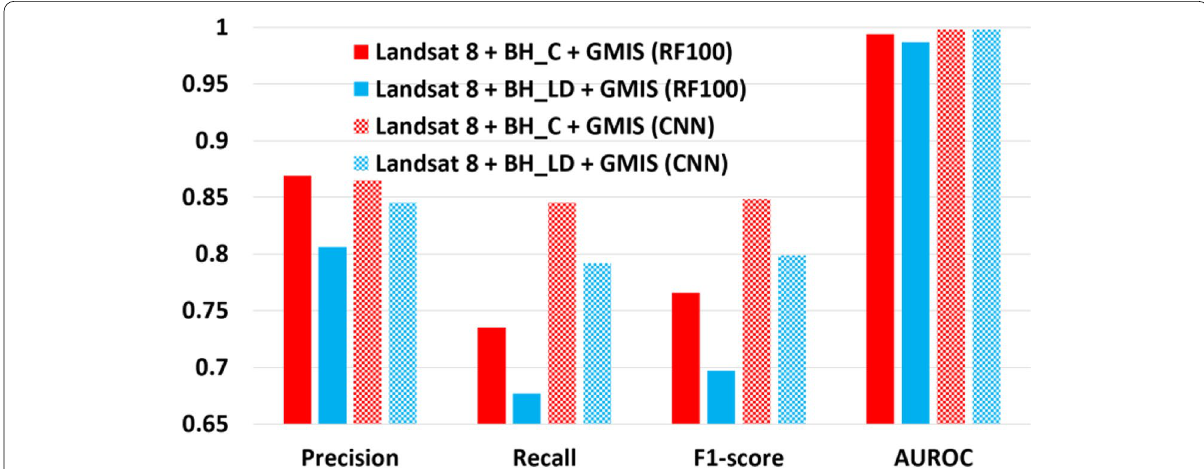
Fig. 15 The macro indices (precision, recall, F1‑score, and AUROC) for different BH datasets, BH_LD (red) and BH_C (blue) using RF100 (solid fill) and CNN (checked fill)